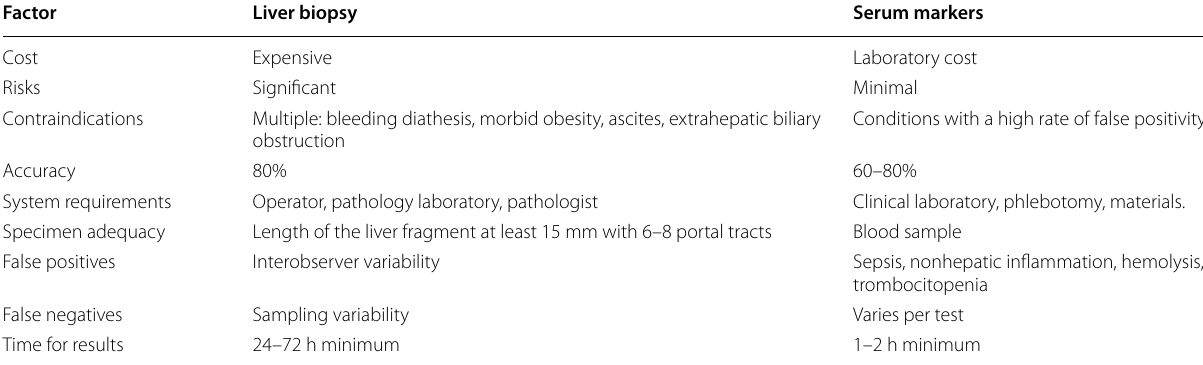
Table 3 Comparison between liver biopsy and serum